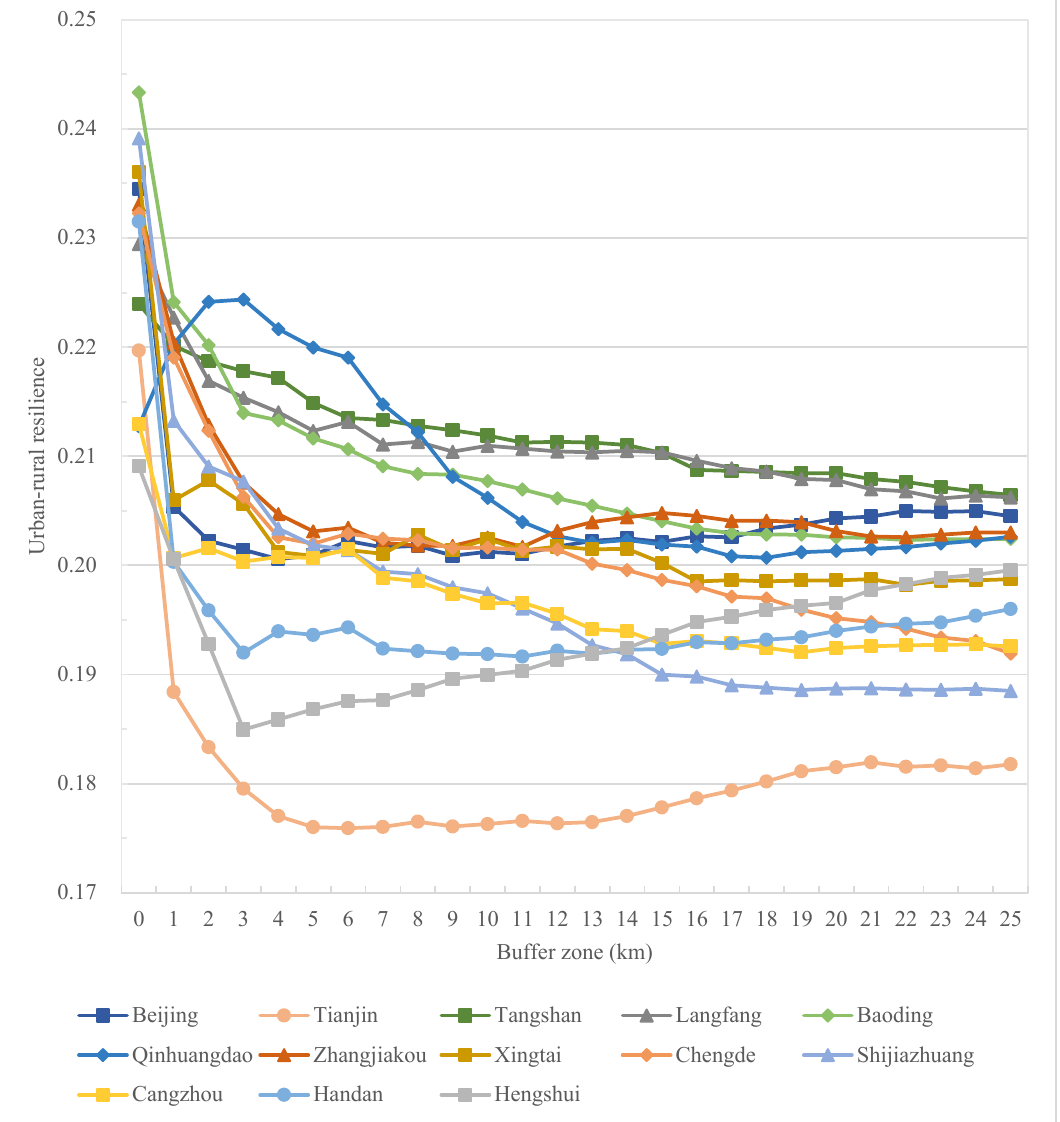
Figure 7. Urban–rural resilience changes along the urban–rural system at the city level in the BHTUA.